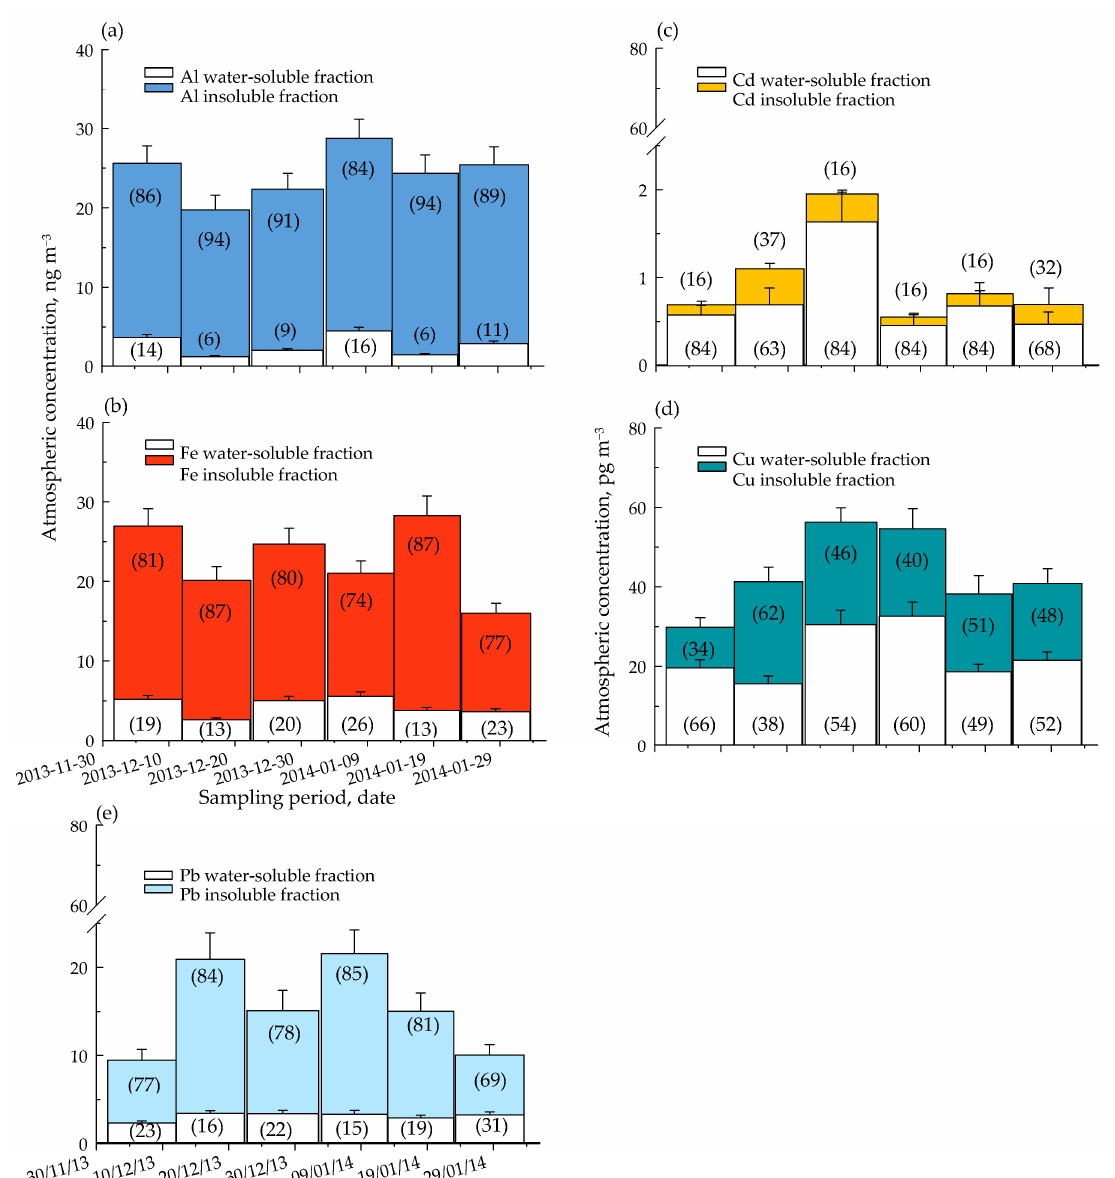
Figure 3. Seasonal evolution of Al ( a ), Fe ( b ), Cd ( c ), Cu ( d ), and Pb ( e ) partitioning between water-soluble and residual fractions in the PM 10 collected at Terra Nova Bay (Ross Sea, Antarctica). In brackets, fraction percentages with respect to the total PM 10 -bound metal concentration.